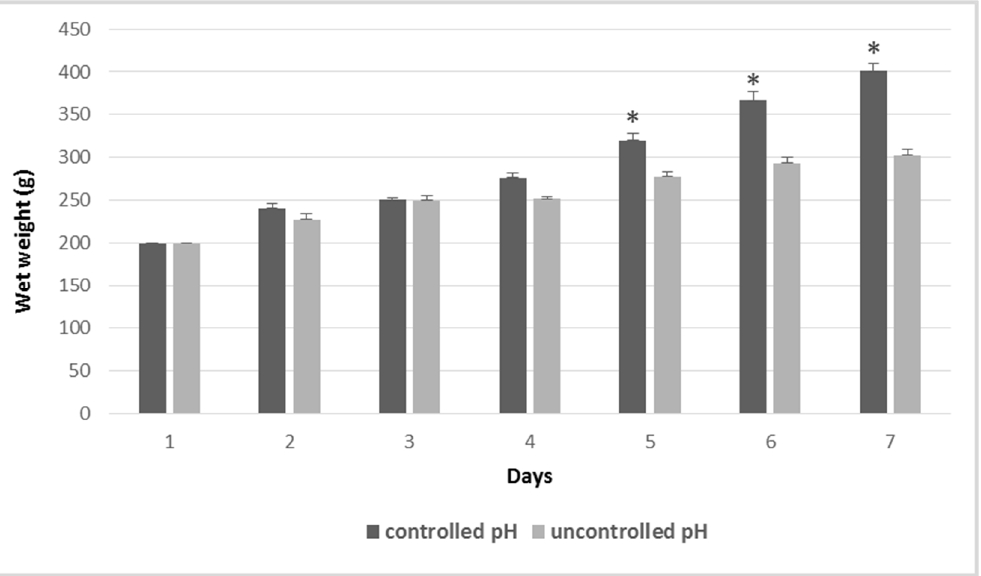
Figure 3. Wet weight (g) and standard error in the different experimental conditions during the culture period. Statistically significant differences ( p < 0.05), showed by asterisks (*) were observed from the 4th day.